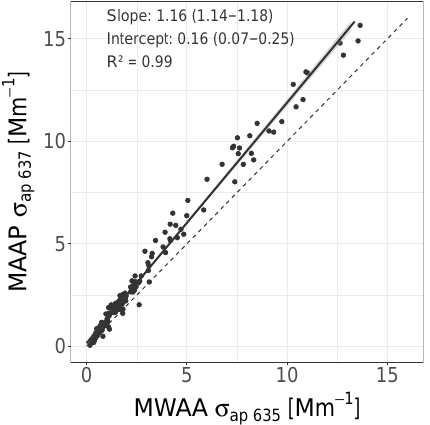
Figure 5. Scatter plot and linear regression of MWAA and MAAP absorption coefficient data. The 1 : 1 relationship is represented by a dashed line. The fit was obtained by applying a standardized major axis